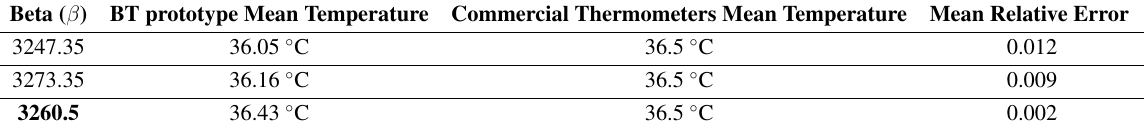
Table 2. Comparative trials between the BT prototype and the commercial thermometer.